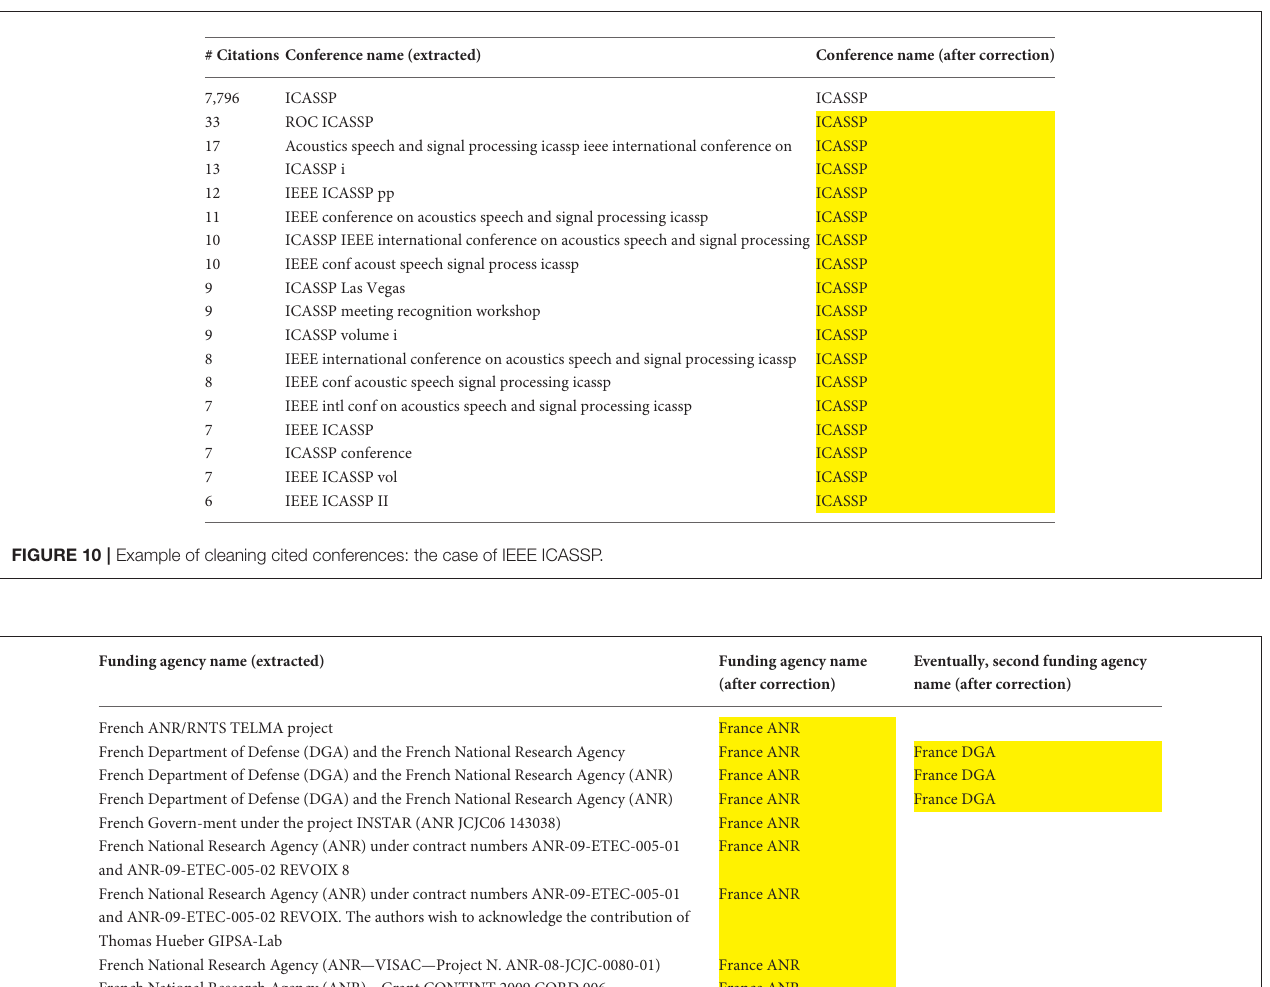
#Citations Conferencename(extracted)